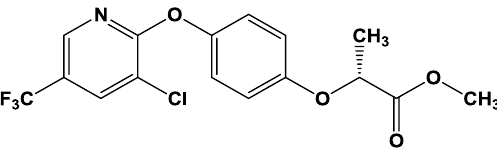
Figure 1. Haloxyfop- p -methyl ester methyl (( R )-2-{4-[3-chloro-5-(trifluoromethyl)-2-